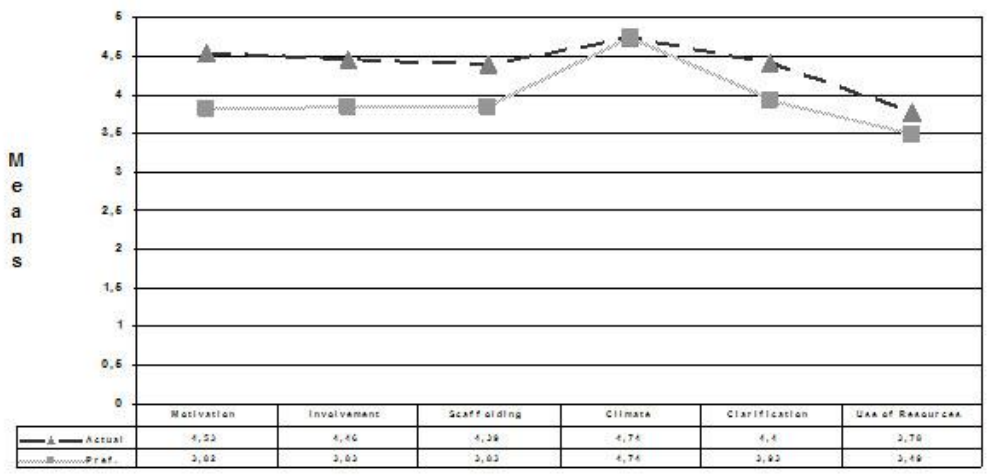
Figure 5. Significant Differences Between Student Actual and Student Preferred Perceptions of the